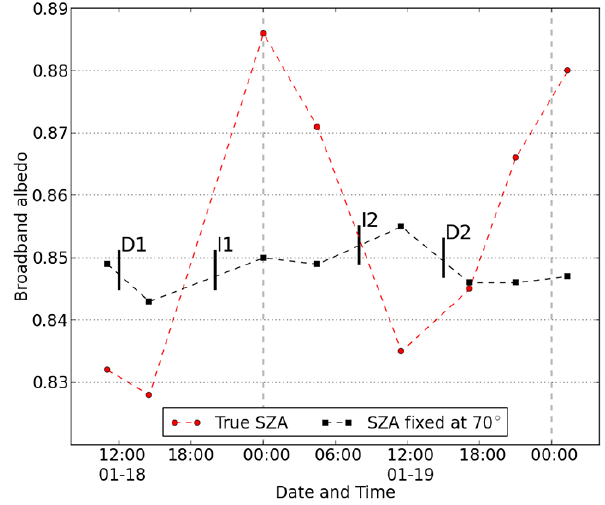
Figure 8. Broadband albedo, 18–19 January 2009 for local time (GMT + 8:00). Calculations were done using DISORT with two sce- narios: SSA variations are always taken into account while the effect of the solar zenith angle (SZA) is either taken into account or not. Date is indicated in the lowest part of the x axis and local time just